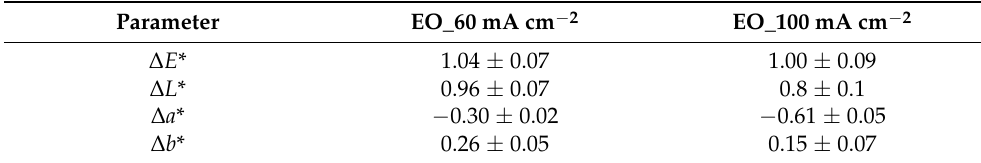
Table 4. Total color difference ( ∆ E *) and differences between L *, a *, and b * obtained from the first reuse cycle.